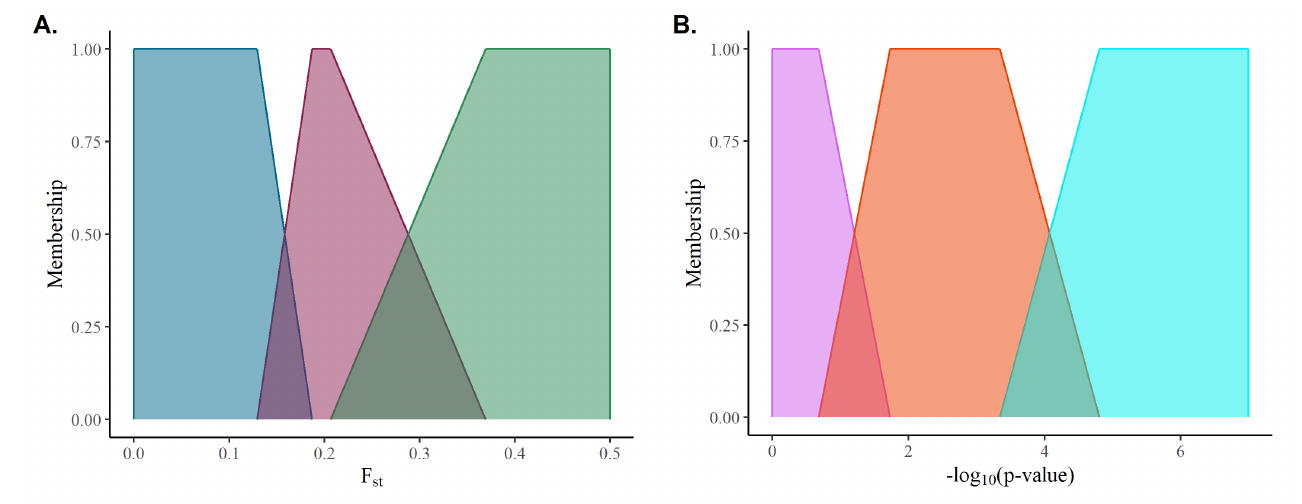
Figure 1. Membership functions for ( A ) F ST scores and ( B ) − log 1 0 ( p